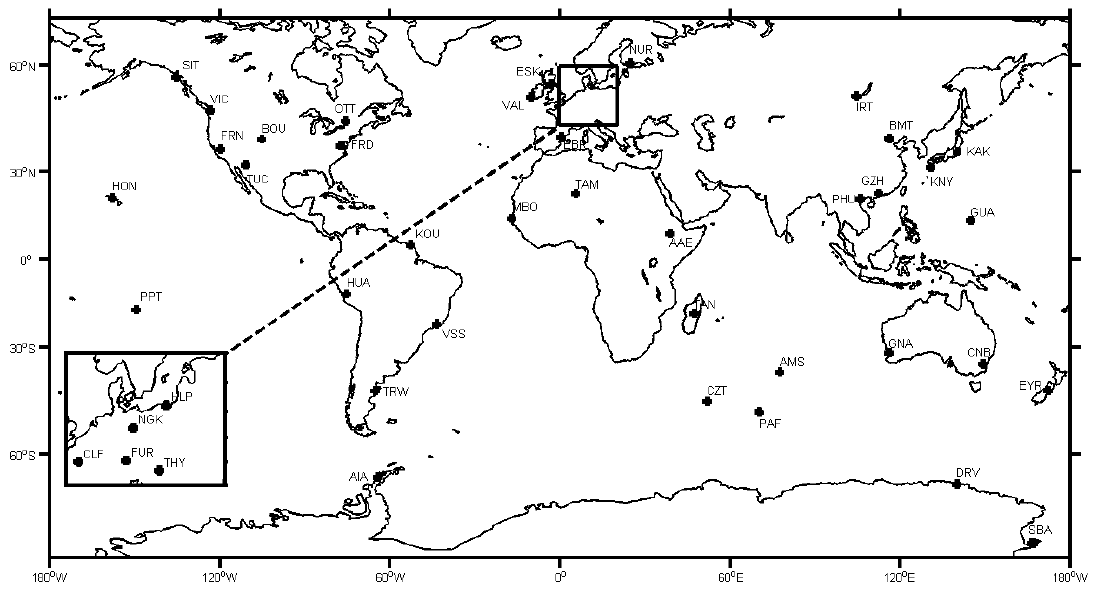
Figure 1. Global distribution of magnetic observatories used in the option one in the training process of the